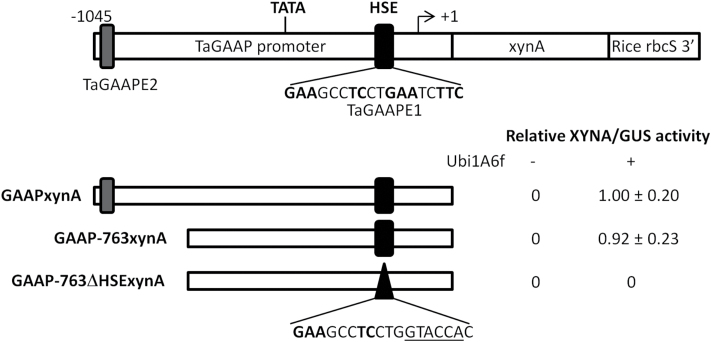
Functional analysis of the TaGAAP promoter in wheat seedlings by promoter truncation and site-directed mutagenesis of TaGAAPE1. A xylanase (XYNA) was used as a reporter for quantitative measurement of expression levels of reporter constructs driven by TaGAAP and its mutant promoters with or without the TaHsfA6f effector construct (Ubi1A6f). Values are means±SD of 3–4 biological replicates. Ubi1:GUS+ was used as a control gene for normalisation of transformation efficiency. Relative expression levels of the reporter gene are expressed as the ratio of XYNA to GUS activity relative to that of GAAPxynA reporter construct with the TaHsfA6f effector construct, which is arbitrarily set as 1. GAAP–763xynA contains a TaGAAP promoter fragment of 763bp upstream of the translation initiation codon. GAAP–763ΔHSExynA contains a mutated TaGAAPE1.